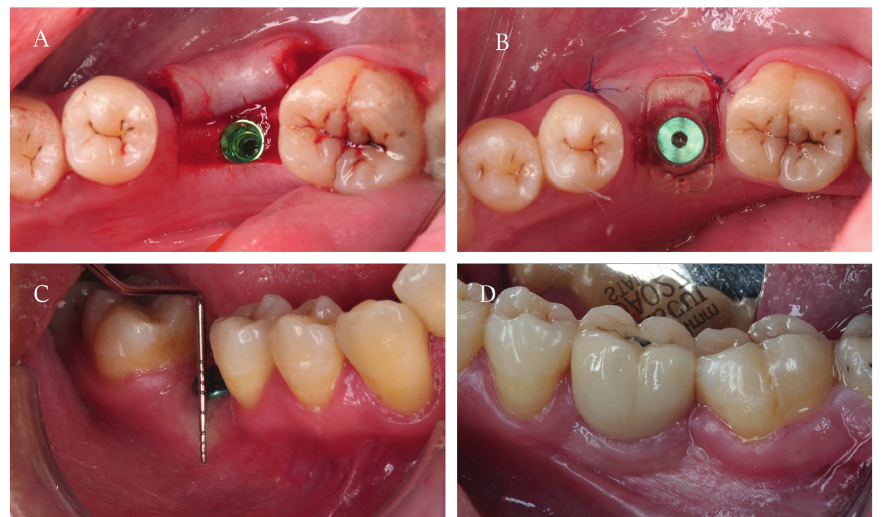
Figure 2: (a) Flap reflection and dental implant placement, (b) healing abutment in place and the flap was secured with the stent, (c) width of KM at 3-month follow-up, and (d) buccal view showing crown in place at 6-month follow-up.